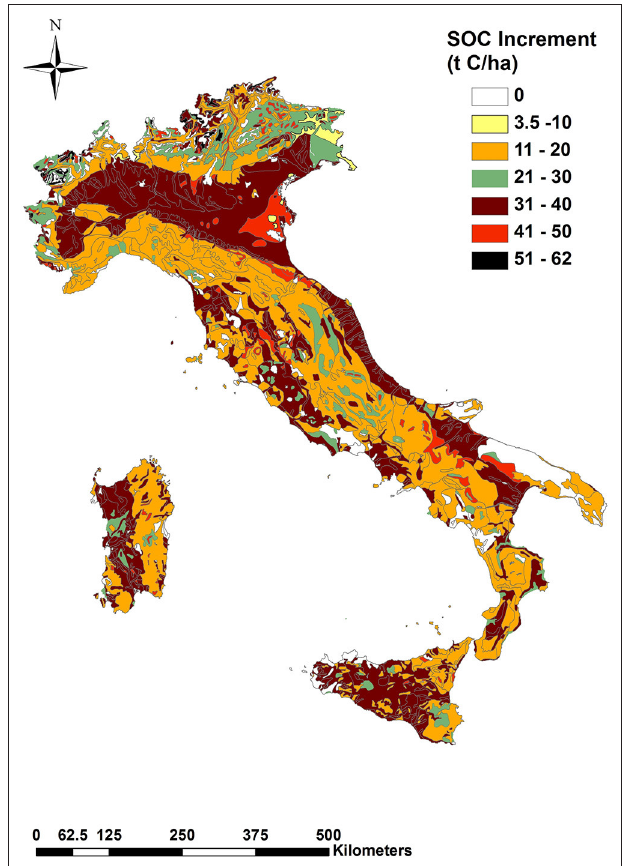
FIGURE 5 | Map of modeled increase in soil organic C (SOC, t ha − 1 ) after 100 years of compost addition (1.0t C ha − 1 y − 1 ) to all the Italian soils with agricultural land use (climate scenario PCM B1). The increase in SOC refers to the business as usual scenario in 2100.